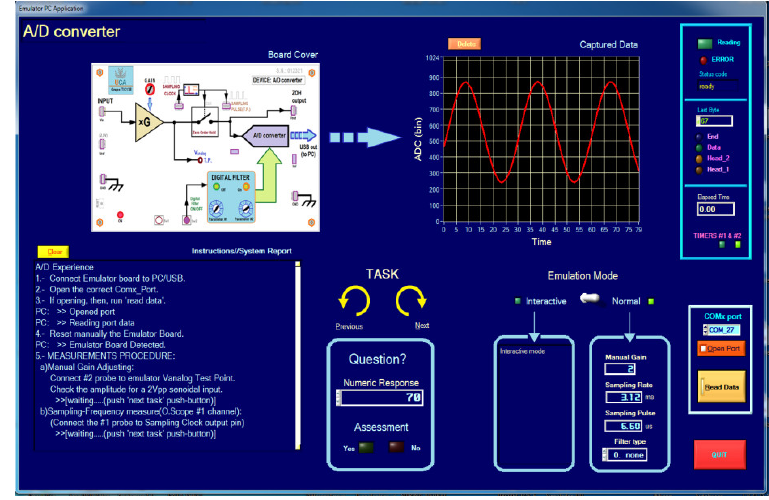
Figure 13. PC application screen for the interactive A/D converter practice.